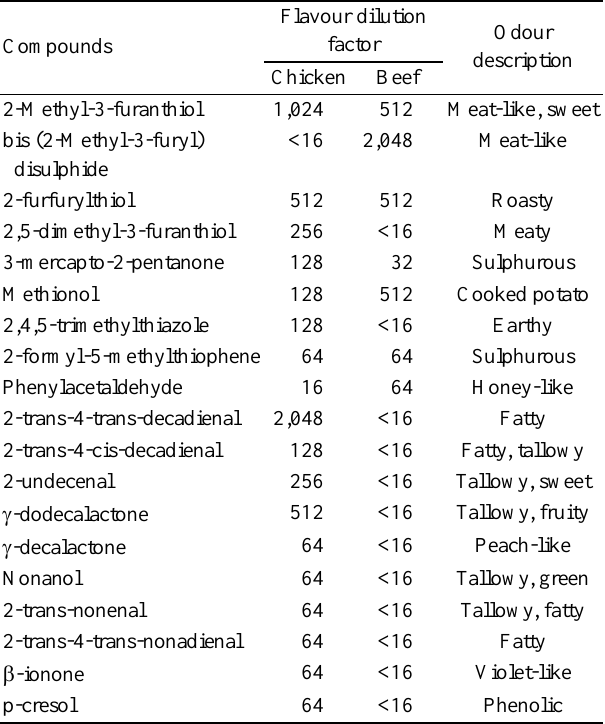
Table 1. Flavour dilution factors of odourants identified in broths from chicken and beef (adapted from Gasser and Grosch, 1990) Flavour dilution Compounds